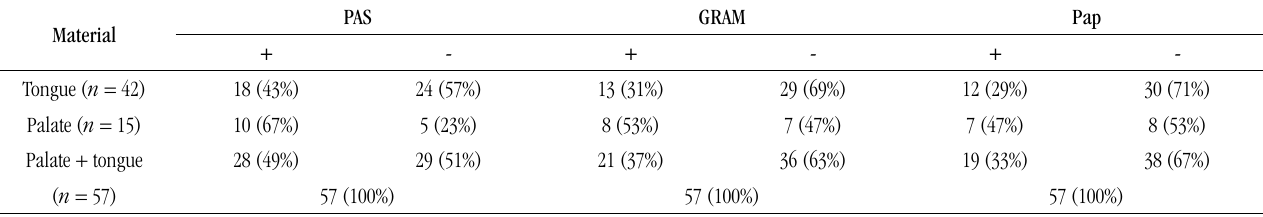
tABLE 2 – Comparative analysis of cytopathological diagnoses of candidiasis